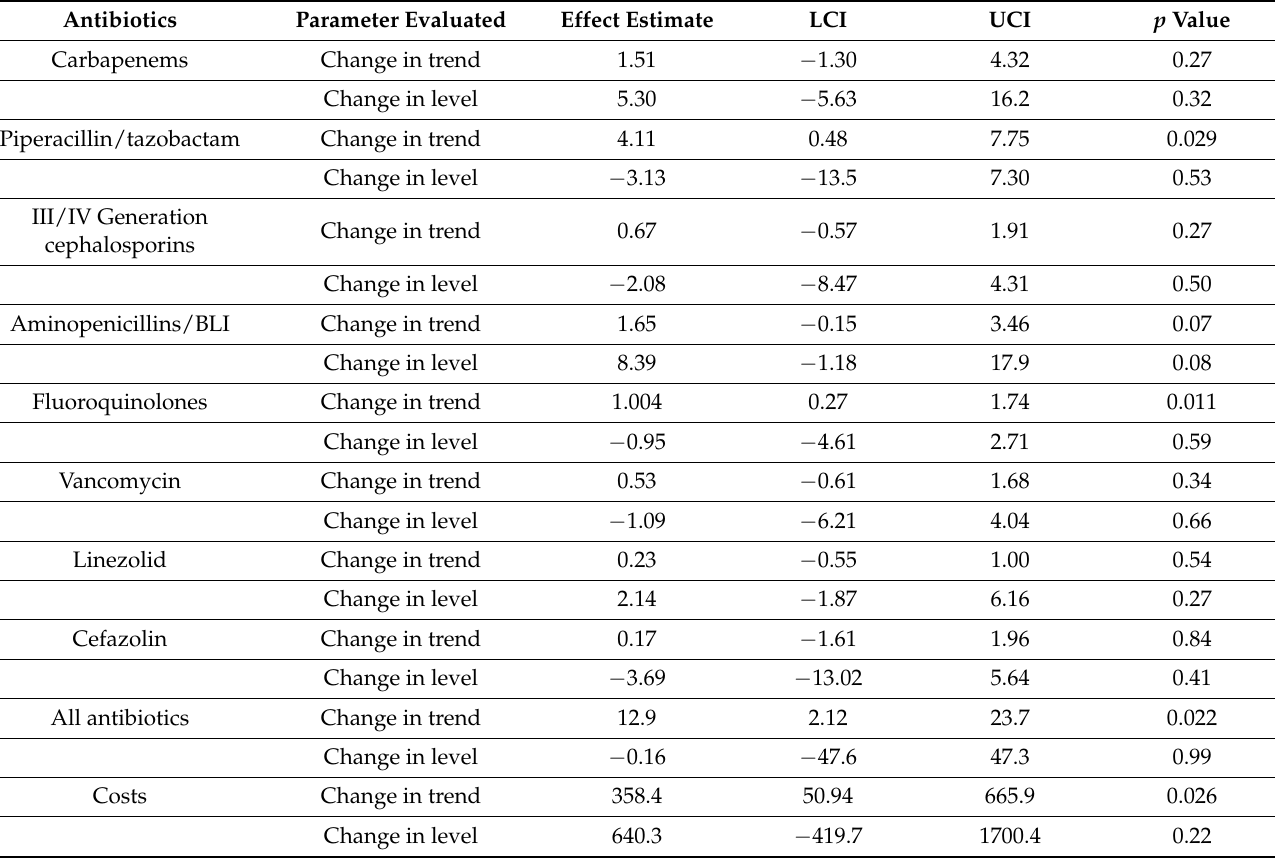
Table 4. Effect of the ASP interruption during COVID-19 pandemic on antibiotic consumption in the 4 units where the program had been active for less than 30 months.